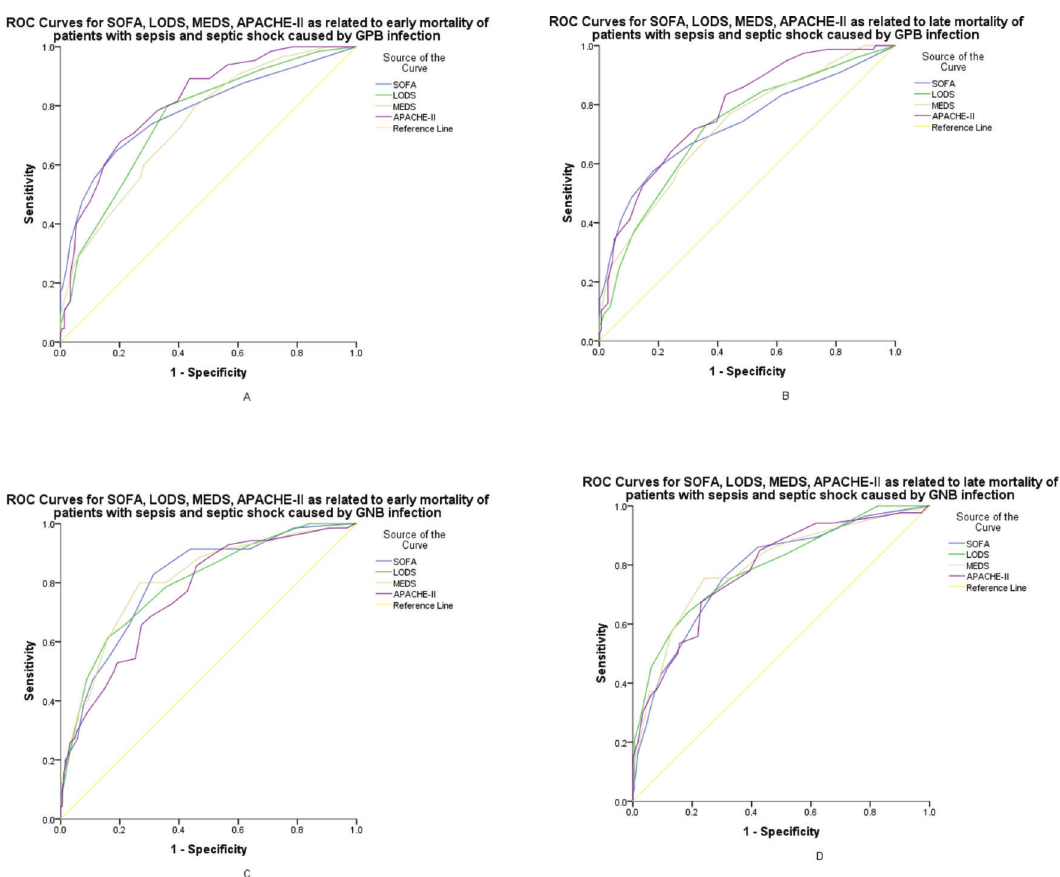
Figure 4 - ROC curves for SOFA, LODS, MEDS, and APACHE-II. A: AUC demonstrates that SOFA measures 0.782 (95% CI, 0.709–0.854), LODS was 0.756 (95% CI, 0.687–0.826), 0.739 (95%CI, 0.669–0.808), and APACHE II measures 0.814 (95% CI, 0.754–0.874) for the prognosis of early mortality of patients with sepsis and septic shock caused by GPB infections. B: AUC demonstrates that SOFA measures 0.731 (95% CI, 0.657–0.805), LODS measures 0.723 (95% CI, 0.652–0.794), MEDS was 0.724 (95%CI, 0.654–0.794), and APACHE II measures 0.780 (95% CI, 0.718–0.843) for the prognosis of late mortality in patients with sepsis and septic shock caused by GPB infections. C: AUC demonstrates that SOFA measures 0.806 (95% CI: 0.747–0.864), LODS measures 0.796 (95% CI, 0.736–0.857), MEDS measures 0.807 (95%CI, 0.746–0.867), and APACHE II measures 0.761 (95% CI, 0.697–0.825) for the prognosis of early mortality in patients with sepsis and septic shock caused by GNB infections. D: AUC demonstrates that SOFA measures 0.782 (95% CI, 0.723–0.842), LODS was 0.795 (95% CI, 0.736–0.853), 0.796 (95% CI, 0.736–0.855), and APACHE II measures 0.783 (95% CI, 0.724–0.842) for the prognosis of late mortality in patients with sepsis and septic shock caused by GNB infections. ROC, receiver operating